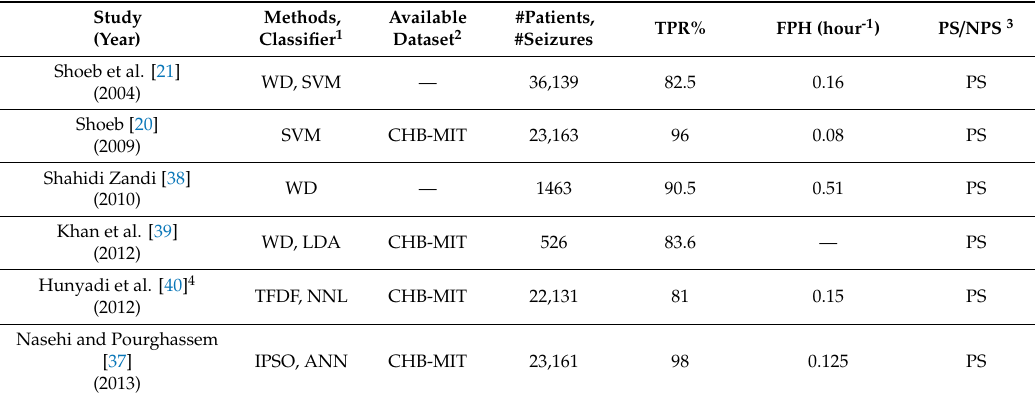
Table 6. Performance of previous